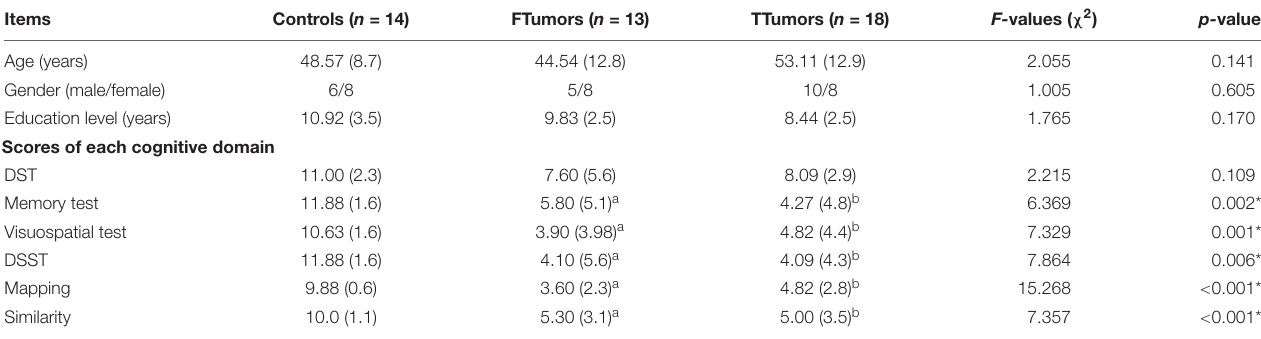
TABLE 1 | Demographics and clinical measures of patients with brain frontal and temporal tumors and control